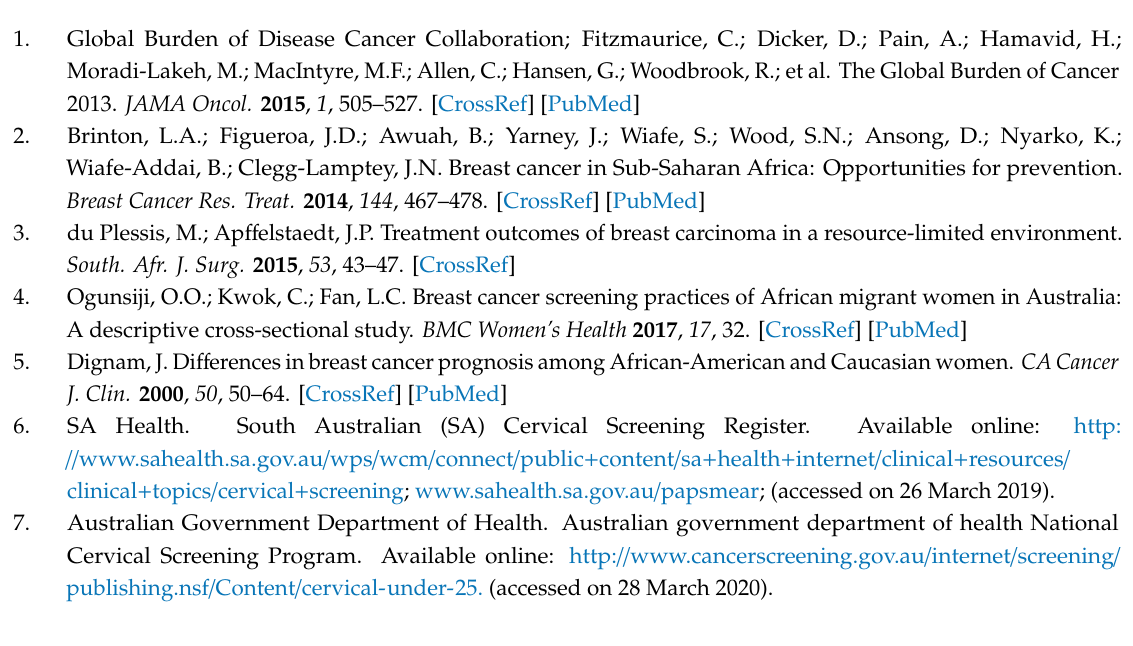
Table S1: Full search strategy; Table S2: JBI quality appraisal and selection tool; Table S3: JBI-data extraction